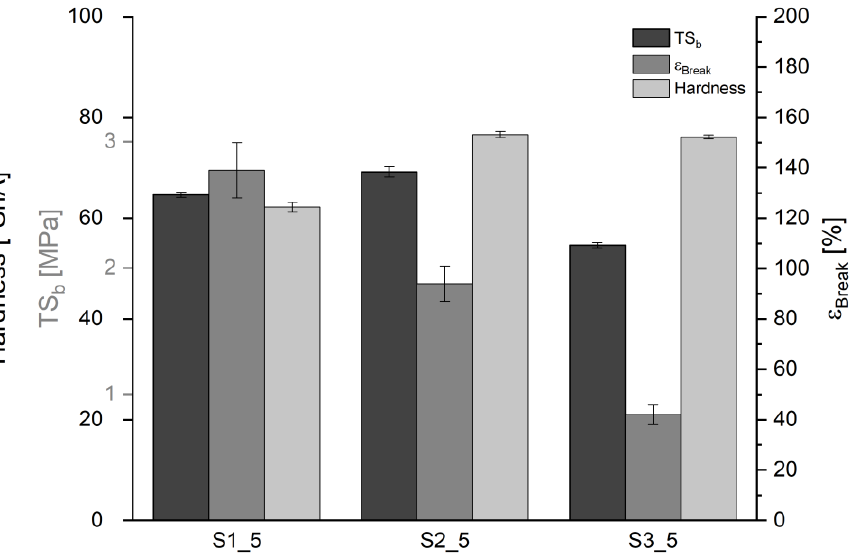
Figure 9. Comparison of T Sb , ε Break , and hardness for bio-TPU–ABW composites containing 5 wt.% of the ABW fillers.